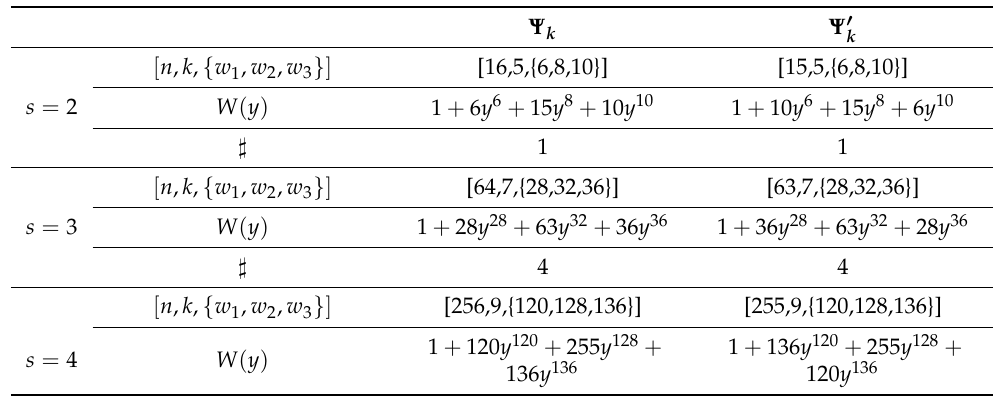
and Ψ (cid:48) S k k